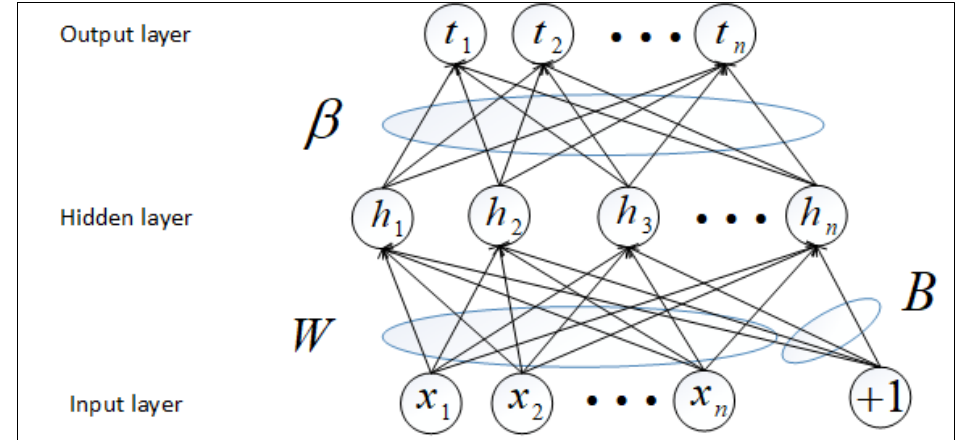
Figure 2. The network topology of classical extreme learning machine (ELM).